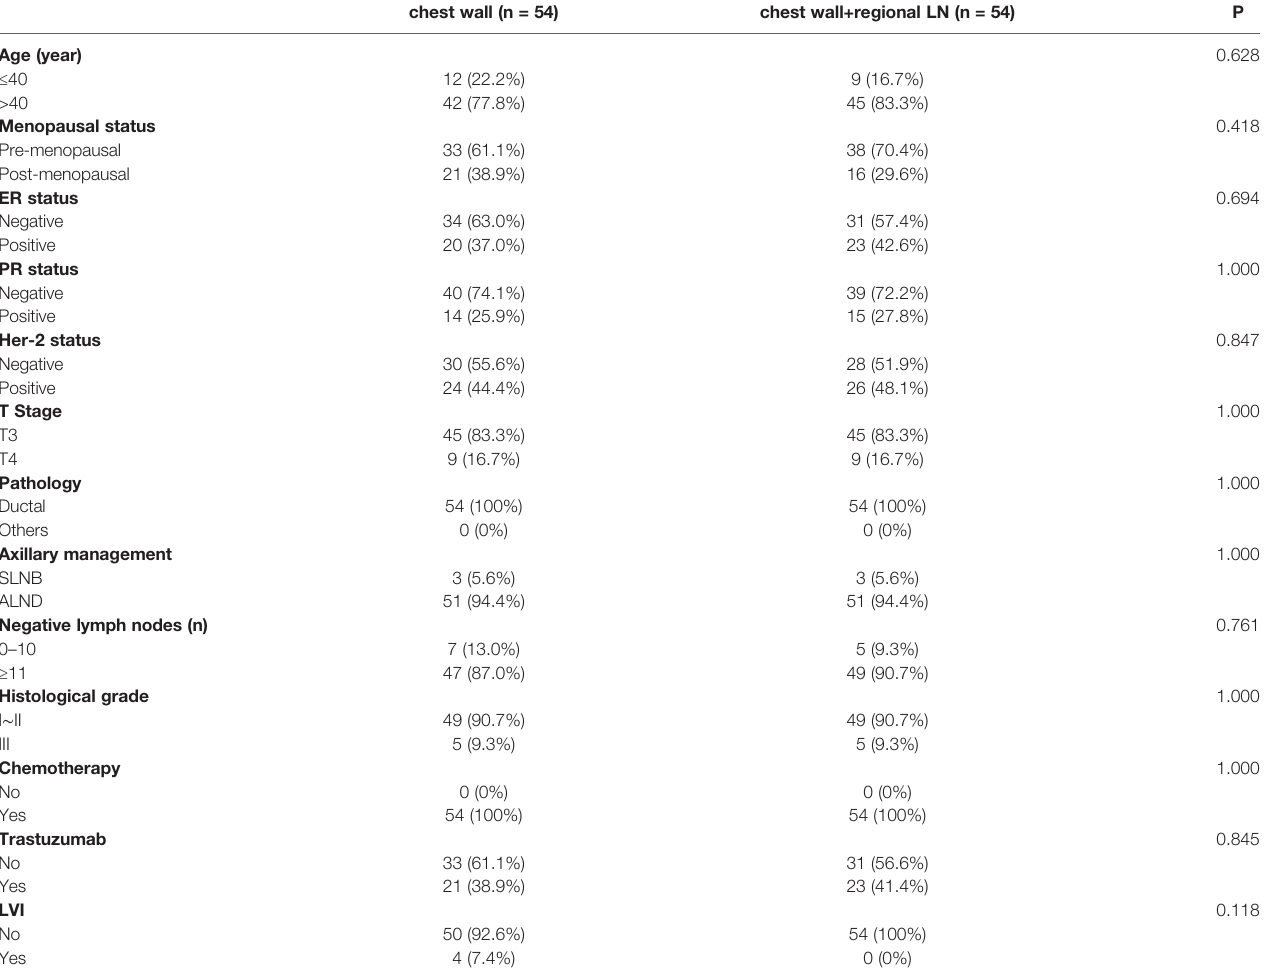
TABLE 4 | Baseline characteristics and treatment patterns for chest wall ± regional LN RT after propensity score